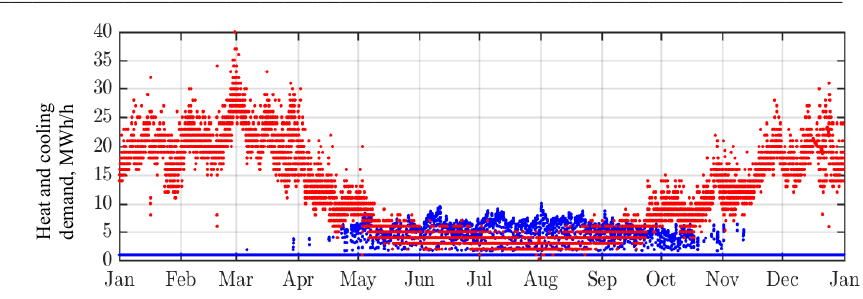
Fig. 2. Heat and cooling demand for